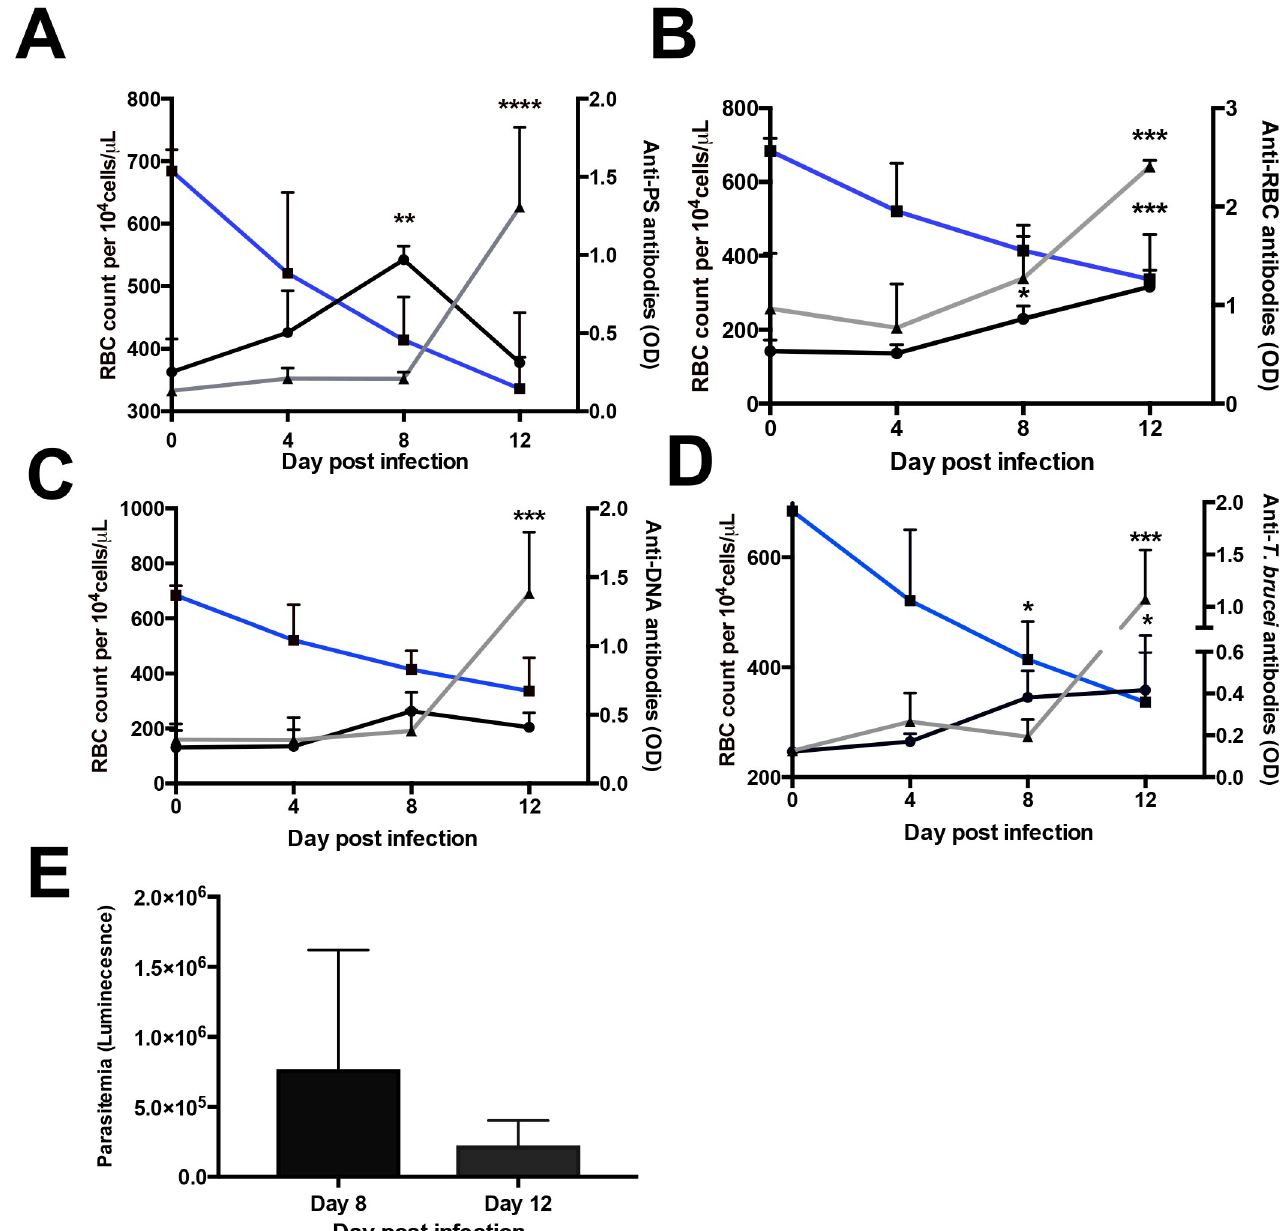
Fig 2. Antibodies and anemia during acute T . brucei infection in mice. Longitudinal analysis of erythrocyte count (blue line), IgM (black line) and IgG (grey line) autoantibodies (a-c) or anti- T . brucei antibodies (d) in T . brucei -infected mice. (e) Bar graph with average parasitemia of mice infected with T . brucei . Line and bar graphs represent the means ± SD of n = 3–6 mice per time point from two independent experiments. Significance between erythrocyte counts or levels of antibodies at any day post-infection compared to day 0 was determined by one-way ANOVA. � p < 0.05, �� p < 0.01, ��� p < 0.001, ���� p <